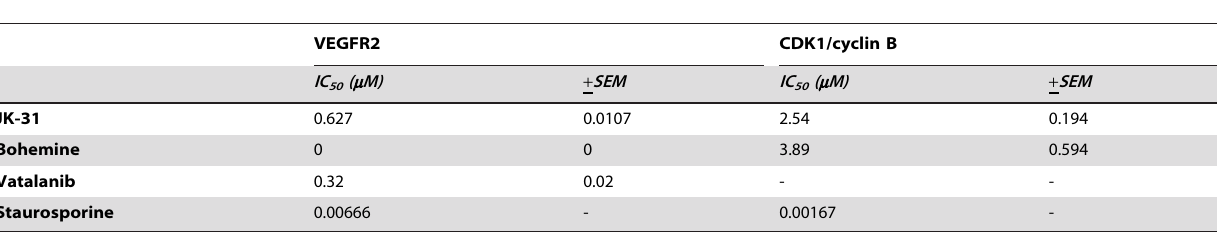
Table 2. Inhibition of VEGFR2 and CDK1/cyclin B kinase activity by JK-31.